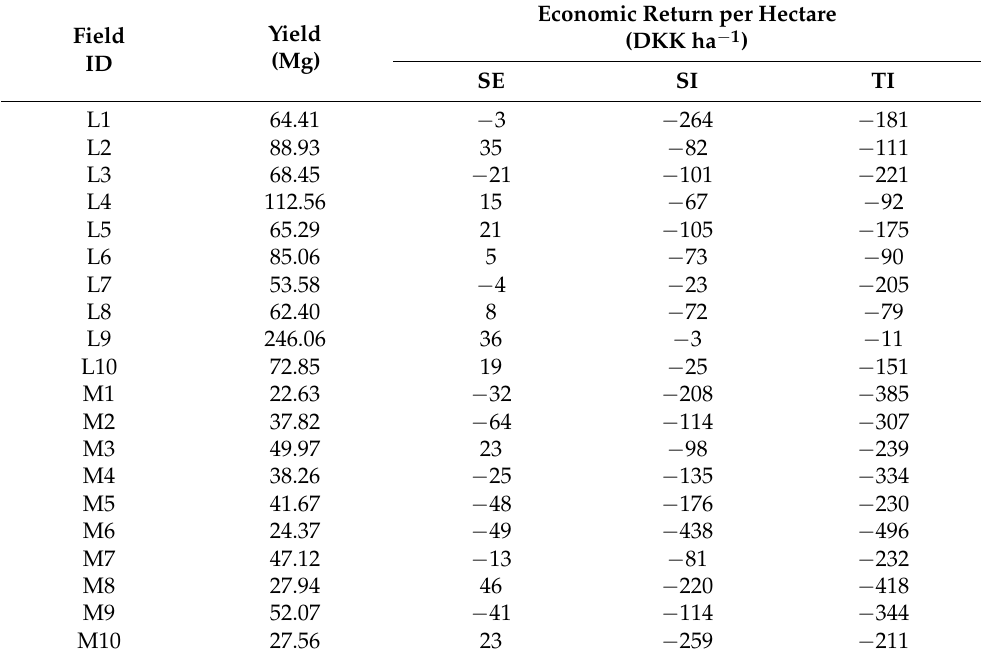
Table 6. Total yields and economic returns for SH cases compared to conventional